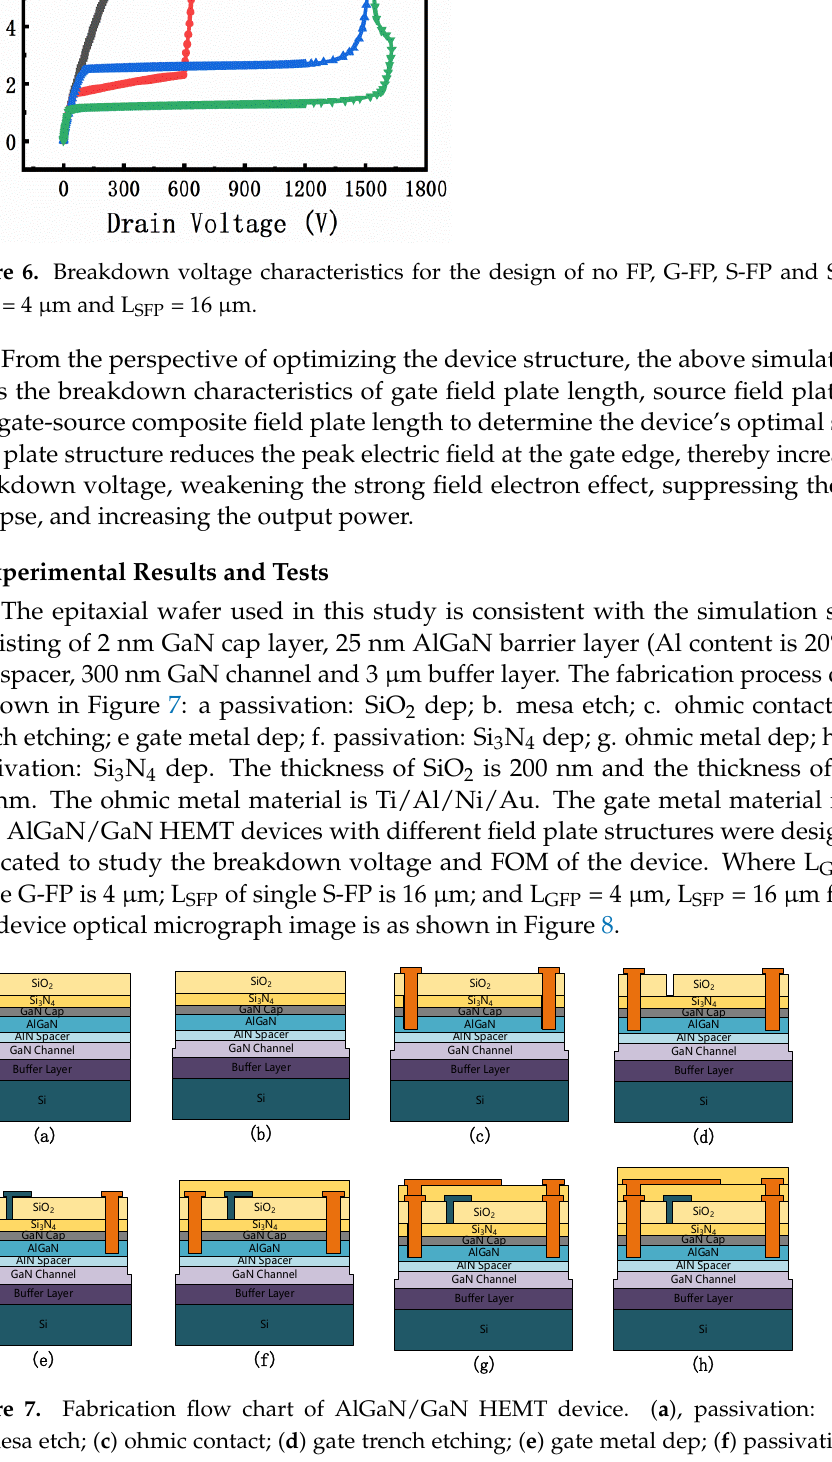
Figure 8. AlGaN/GaN HEMT device optical micrograph. Figure 9 shows the output characteristics of four different field plate structures. The source-drain voltage (Vds) varies from 0 V to 11 V, and the gate voltage (VG) varies from −4 V to 4 V. From the output curve, it can be seen that when VG = 4 V, the maxi- mum saturation current (Ids) of no FP, G-FP, S-FP, and SG-FP are 476 mA/mm, 477.1 mA/mm, 487 mA/mm, and 494.7 mA/mm, respectively. The difference is small, which is related to the density of two-dimensional electron gas [16].